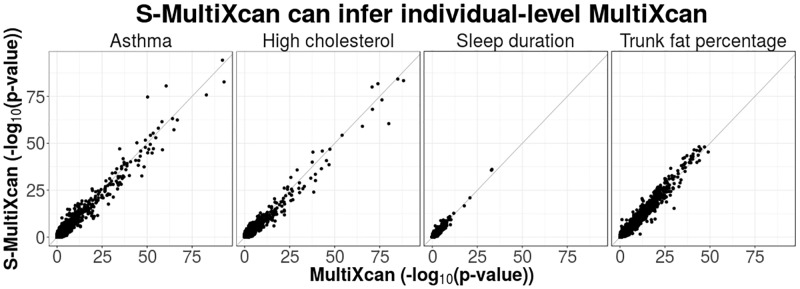
Comparison between S-MultiXcan and individual-level MultiXcan.This figure compares S-MultiXcan to MultiXcan in four UK Biobank phenotypes. GTEx individuals were used as a reference panel for estimating expression correlation in the study population. The summary data-based method shows a good level of agreement with the individual-based method. In cases where the LD-structure between reference and study cohorts is mismatched, the summary-based method becomes less accurate. For example in Asthma, two genes are overestimated; however it tends to be conservative for most genes.